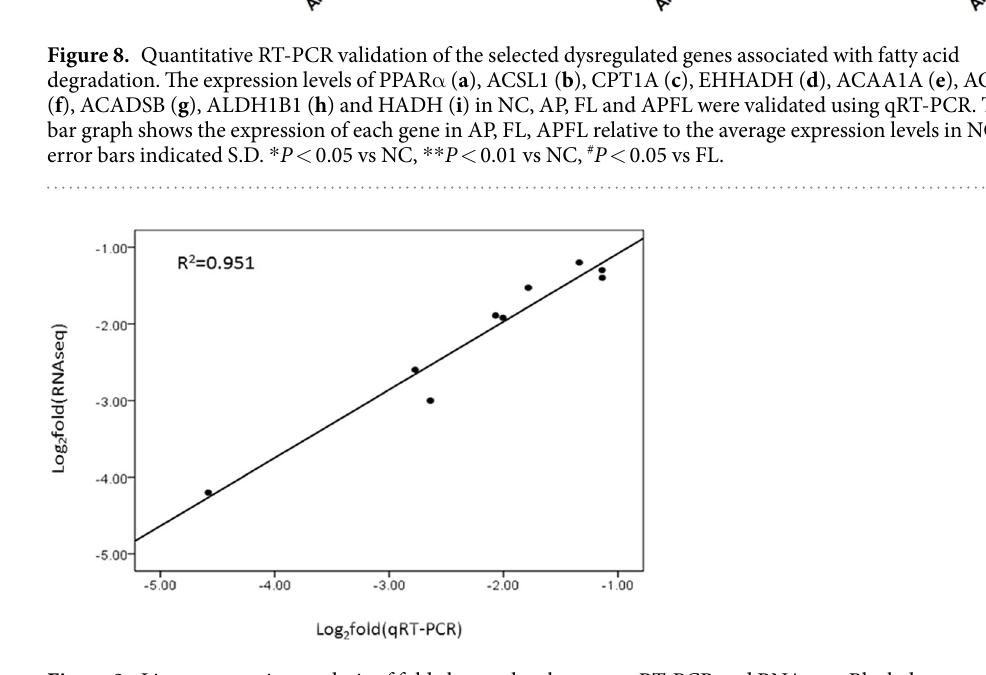
reviewed and protocols were approved by Xijing Hospital Animal Care and Use Committee. All methods were performed in accordance with NIH guidelines.